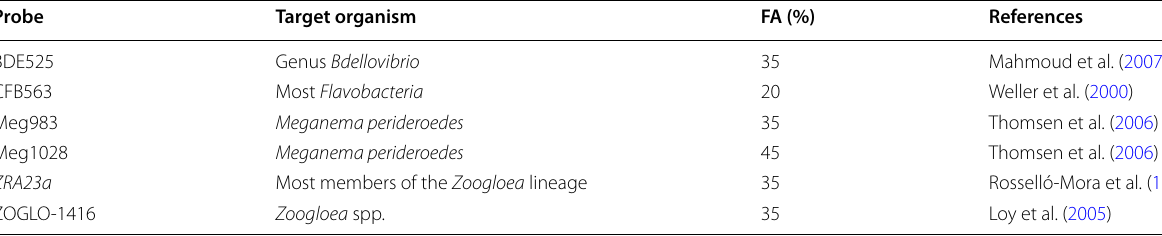
FA formamide concentration in the hybridization buffer